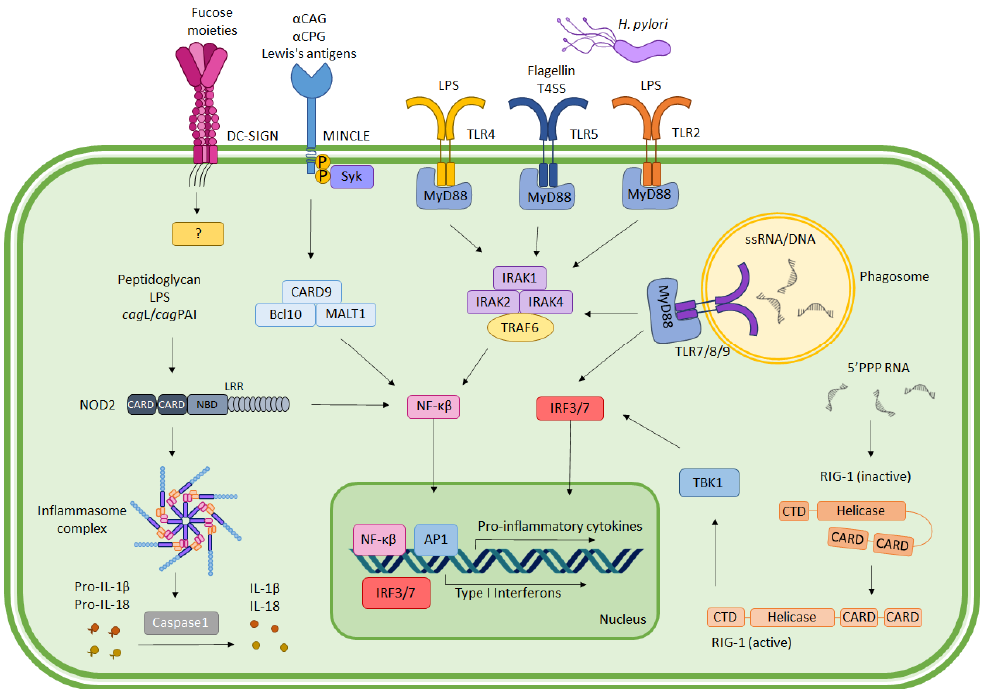
Figure 1. Activation of pattern recognition receptors (PRRs) by H. pylori . Toll-like receptors (TLRs) 2, 4, and 5 recognize different extracellular bacterial factors to mediate MyD88-dependent or -inde- pendent activation of proinflammatory cytokine secretion. TLR7/8/9 recognize ingested bacterial DNA or single-stranded RNA (ssRNA) in phagosomes for activation of type I interferons produc- tion. Transcription factors NF- ĸ B, activator protein 1 (AP1), and IRF3/7 play prominent roles in transactivation of inflammatory cytokines and type I interferons. C-type lectin-like receptors (CLRs) including MINCLE also induce NF- ĸ B through interaction with CARD9/BCL10/MALT1. DC-SIGN transmits signals through an unknown pathway during H. pylori infection. NOD-like receptors (NLRs) such as NOD2 activate the inflammasome complex to induce production and maturation of IL-1 β and IL-18. RIG-I-like receptors (RLRs) such as retinoic acid-inducible gene I (RIG-I) are acti- vated by 5 ′ triphosphate (PPP) single-stranded RNA, leading to conformation change, which subsequently activates Tank-binding kinase 1 (TBK1). This, in turn, causes production of type I interferons through IRF3/7